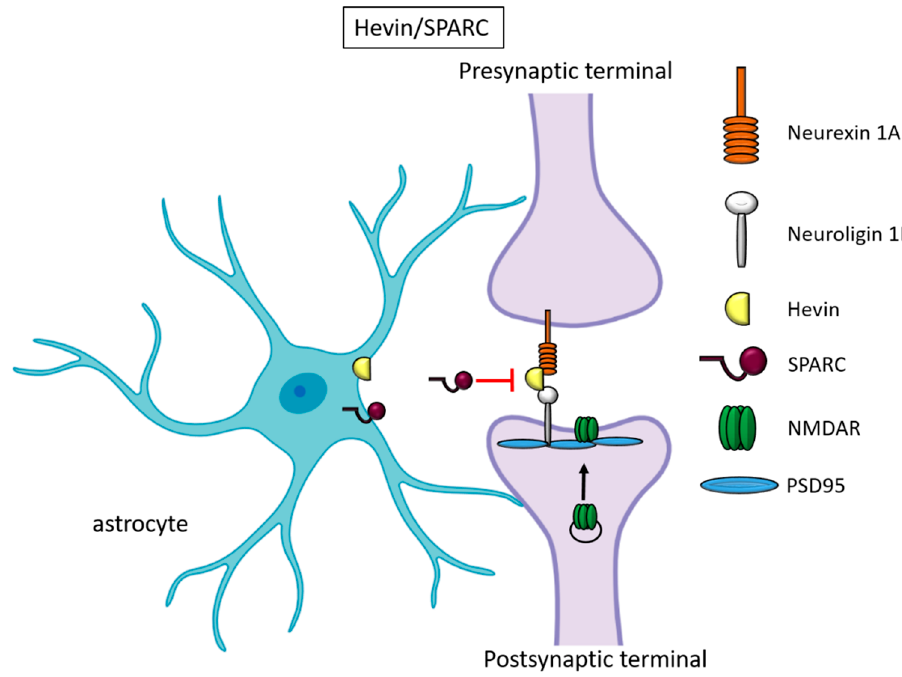
Figure 2. Hevin and SPARC. Astrocyte-secreted Hevin bridges presynaptic neurexin and postsynaptic neuroligin to favor the recruitment of PSD95 and NMDAR subunits at the synapse. SPARC on the contrary antagonizes Hevin’s effect with a still unknown mechanism.